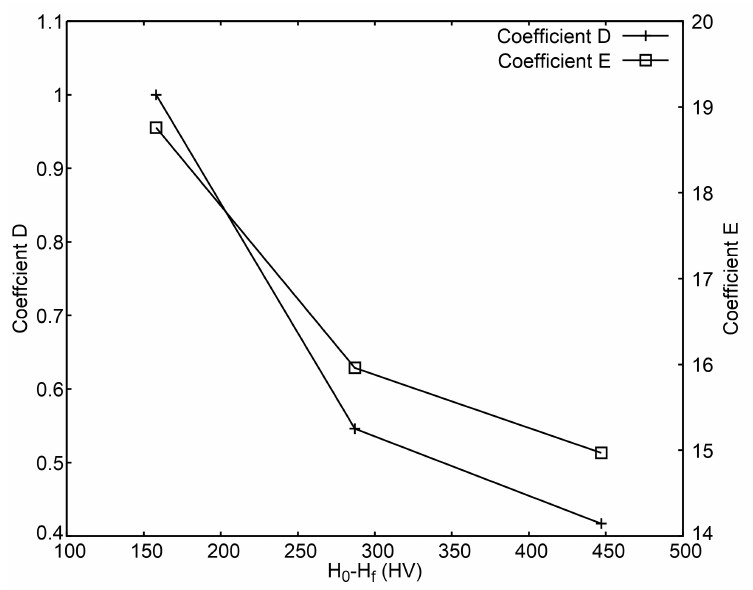
Figure 10. Coefficients D and E as a function of H 0 − H f